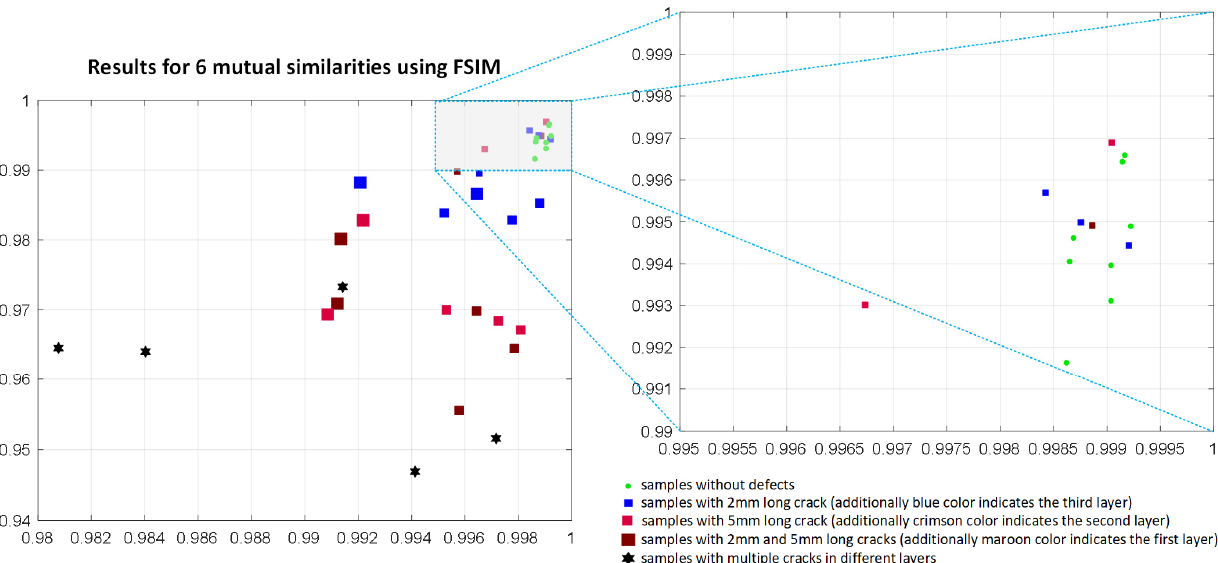
Figure 20. Results obtained applying six mutual comparisons employing the FSIM metric using the maximum and average of its values calculated for 17 images corresponding to various frequencies used in experiments.